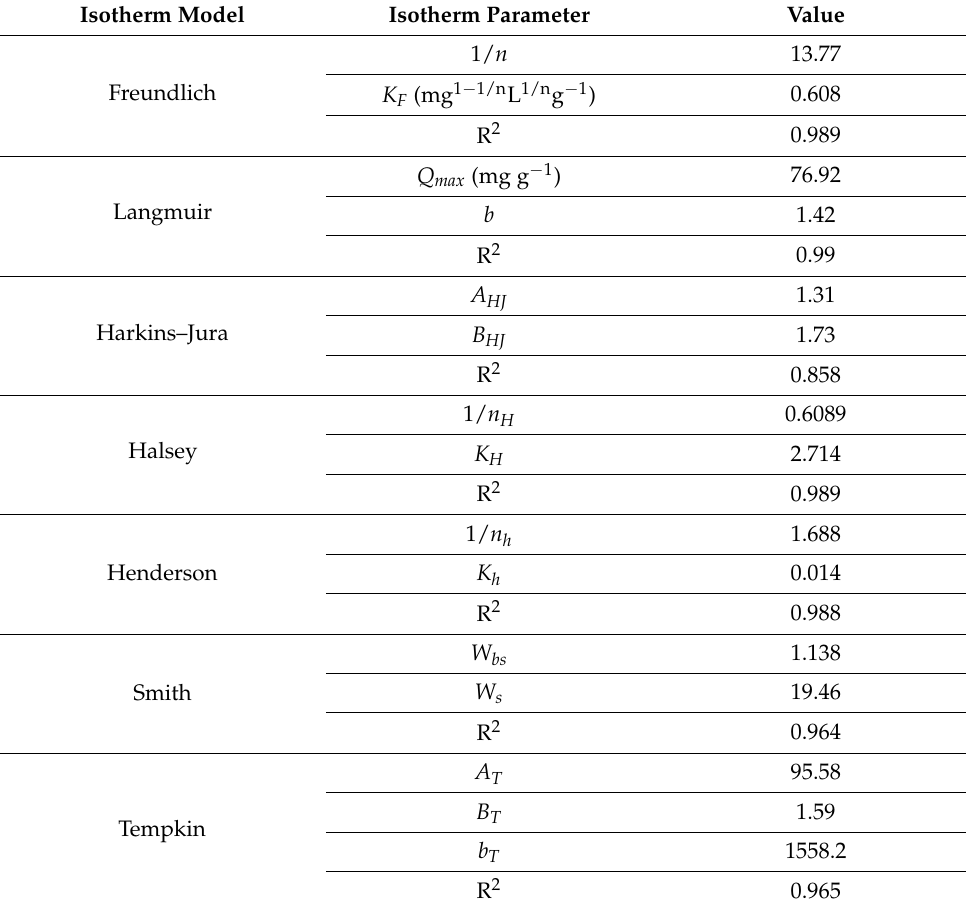
Figure 17. Linear Tempkin isotherm of the removal of IV2R. Table 2. Factors of the isotherm models from nonlinear and linear solvation.